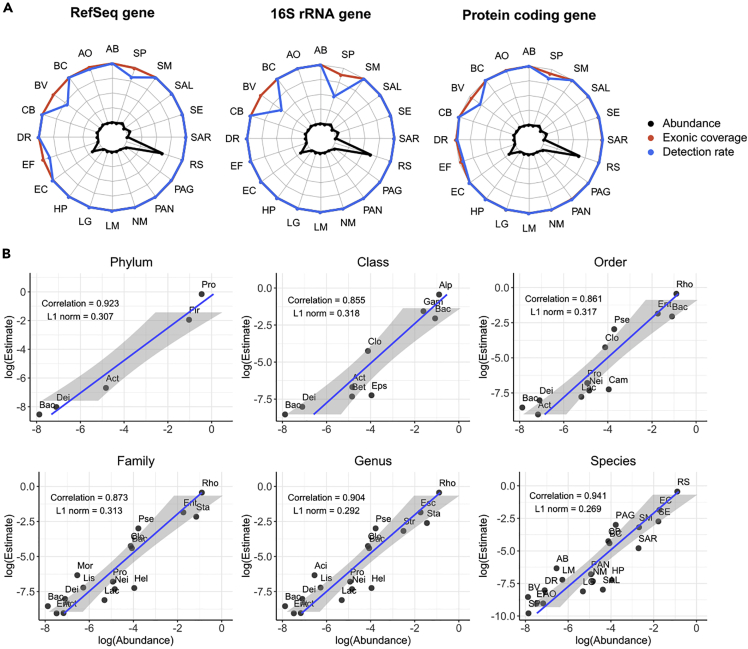
Taxonomic Profiling Results for HM-277D Datasets(A) Gene identification performance of 20 bacterial strains. Three gene sets (RefSeq, 16S rRNA, protein coding) were evaluated. Colors indicate different metrics (exonic coverage and detection rate). Exonic coverage (orange) is the percentage of exonic region covered by at least one readout of all exons. Detection rate (blue) is the percentage of genes with coverage depth >1 and exonic coverage >50% out of all genes. Gold standard abundance of each strain was indicated in black.(B) Bacterial abundance estimation. Scatterplots abundance estimates versus gold standard abundances from HM-277D mock community across taxonomic ranks. Abundances were converted to log scale to facilitate viewing. Pearson correlation and L1 norm were utilized to quantify the performance. Estimates consistently share a good agreement with gold standard across ranks with correlation >0.85 and L1 norm <0.32. Abbreviations for bacterial name above the species level are listed below. Phylum level: Actinobacteria, Bacteroidetes (Bac), Deinococcus-Thermus (Dei), Firmicutes (Fir), Proteobacteria (Pro); Class level: Actinobacteria (Act), Alphaproteobacteria (Alp), Bacilli (Bac), Bacteroidia (Bact), Betaproteobacteria (Bet), Clostridiales (Clo), Deinococcus (Dei), Epsilonproteobacteria (Eps), Gammaproteobacteria (Gam); Order level: Actinomycetales (Act), Bacillales (Bac), Bacteroidales (Bact), Campylobacterales (Cam), Clostridiales (Clo), Deinococcales (Dei), Enterobacteriales (Ent), Lactobacillales (Lac), Neisseriaceae (Nei), Propionibacteriaceae (Pro), Pseudomonadales (Pse), Rhodobacterales (Rho); Family level: Actinomycetaceae (Act), Bacillaceae (Bac), Bacteroidaceae (Bact), Clostridiaceae (Clo), Deinococcaceae (Dei), Enterobacteriaceae (Ent), Enterococcaceae (Ent), Helicobacteraceae (Hel), Lactobacillaceae (Lac), Listeriaceae (Lis), Moraxellaceae (Mor), Neisseriaceae (Nei), Propionibacteriaceae (Pro), Pseudomonadaceae (Pse), Rhodobacteraceae (Rho), Staphylococcaceae (Sta); Genus level: Acinetobacter (Act), Actinomyces (Act), Bacillus (Bac), Bacteroides (Bact), Clostridium (Clo), Deinococcus (Dei), Enterococcus (Ent), Escherichia (Esc), Helicobacter (Hel), Lactobacillus (Lac), Listeria (Lis), Neisseria (Nei), Propionibacterium (Pro), Pseudomonas (Pse), Rhodobacter (Rho), Staphylococcus (Sta), Streptococcus (Str).